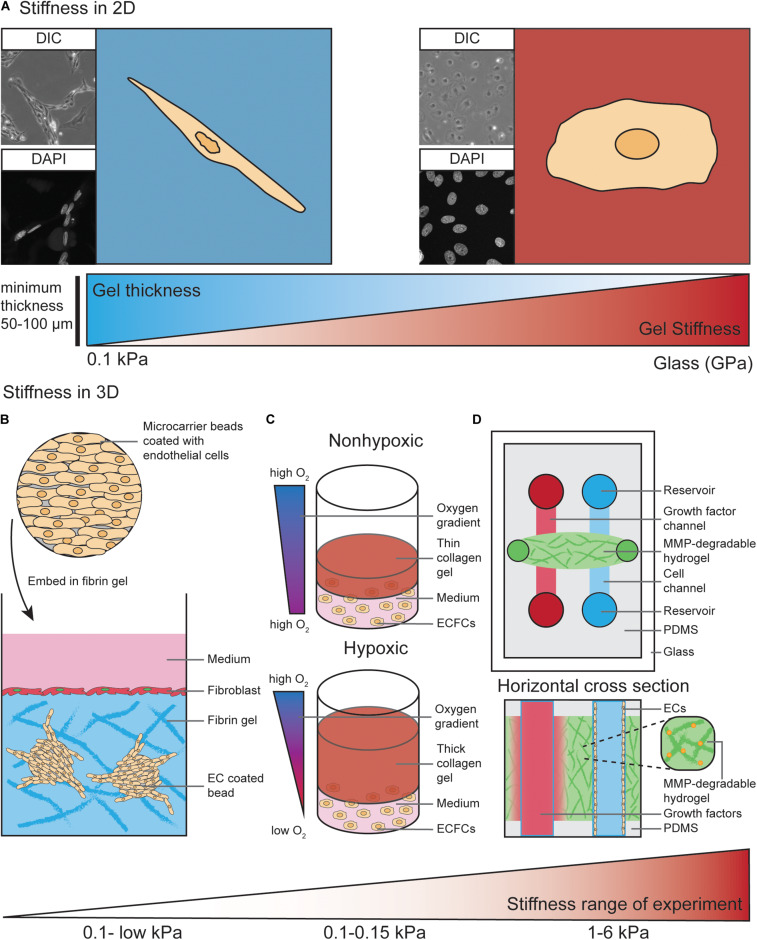
Models to study EC behavior regulated by matrix stiffness. (A) ECs cultured on 2D substrates with different stiffness ranging from 0.1 kPa up to GPa (glass) display different morphologies. As an example, on soft substrates human dermal lymphatic endothelial cells (HDLECs, C-12216, PromoCell, Heidelberg, Germany) show a spindle-shaped morphology with a distorted and elongated nucleus and form networks via their cell–cell interactions. On stiff substrates HDLECs flatten out and preferably undergo cell-substrate interactions compared to HDLECs cultured on soft substrates. ECs can “feel” up to several micrometers deep into a compliant substrate, suggesting a minimum hydrogel thickness of 50–100 μm is necessary to analyze ECs on compliant 2D substrates. (B) ECs coated on cytodex microcarrier beads are embedded into a fibrin hydrogel to study 3D in vitro angiogenic sprouting. Fibroblast are layered on top of the gel to provide necessary factors to promote EC sprouting and lumenisation. The stiffness range of this assay is very low due to the use of natural materials such as fibrin or collagen. (C) Encapsulation of endothelial colony-forming cells (ECFCs) in 3D collagen gels with varying thickness provides a temporal hypoxic gradient, where thick gels model hypoxia and thin gels normoxia. Increased matrix stiffness of the 3D collagen gels is performed by crosslinking and results in a stiffness range of 0.1–0.15 kPa. (D) Top view and horizontal cross section of PDMS-hydrogel microchannel containing non-swelling MMP-degradable DexMA hydrogel. This allows ECs grown in one channel to migrate toward a growth factor gradient formed by diffusion of growth factors from the other channel. Incorporation of the MMP-degradable peptide crosslinkers into the synthetic hydrogel makes the stiffness variable within a range of 1–6 kPa, compared to non-variable standard hydrogels used in Figures 1F–H.